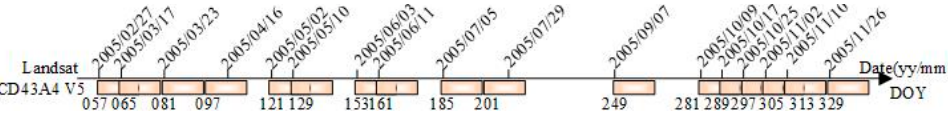
Figure 4. Landsat and MODIS in 2005 were used in the spatiotemporal fusion algorithm screening scheme establishment, where V5 represents version 5 of the MCD43A4 datasets. The date shows the observation date of the Landsat image, while the DOYs show the first day of year of the MCD43A4 16-day composite images. Table 1. List of high-resolution images where ZY-03 and GF-1 represent the Chinese Ziyuan 3 and Gaofeng 1 satellites. Pan refers to the panchromatic band, MS refers to the multispectral band, and B, G, R, and NIR refer to blue, green, red, and near-infrared, respectively. “-” represents null.